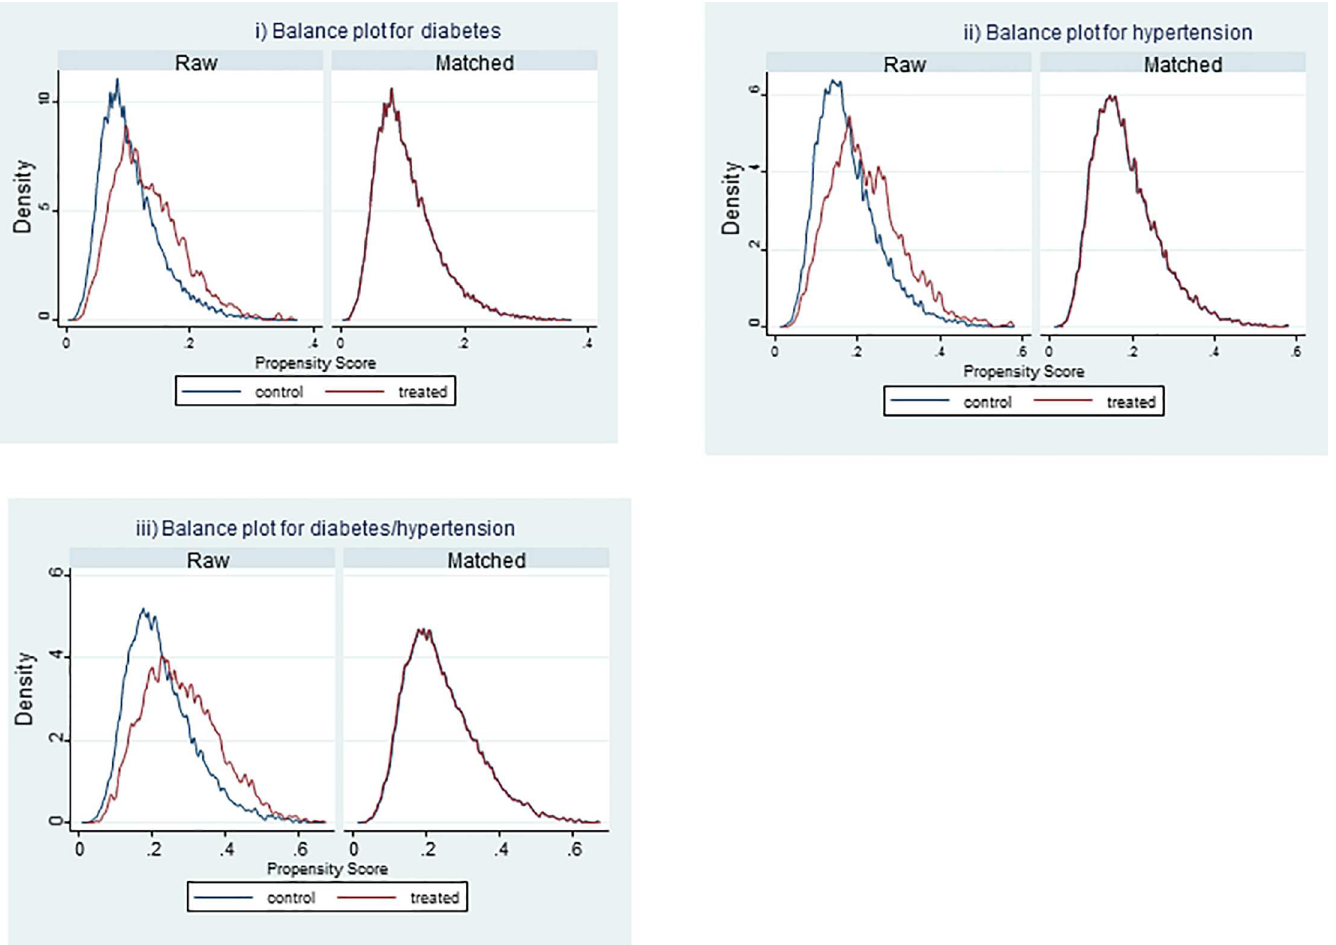
Fig 2. Balance plots for the matching procedure: i) households having members with diabetes; ii) households having members with hypertension; iii) households having members with either diabetes or hypertension.